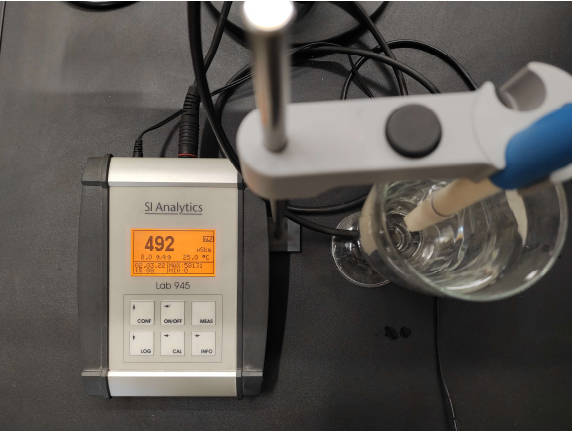
Figure 7. Measuring the electrical conductivity of water using the SI Analytics Lab 945 conductometer.